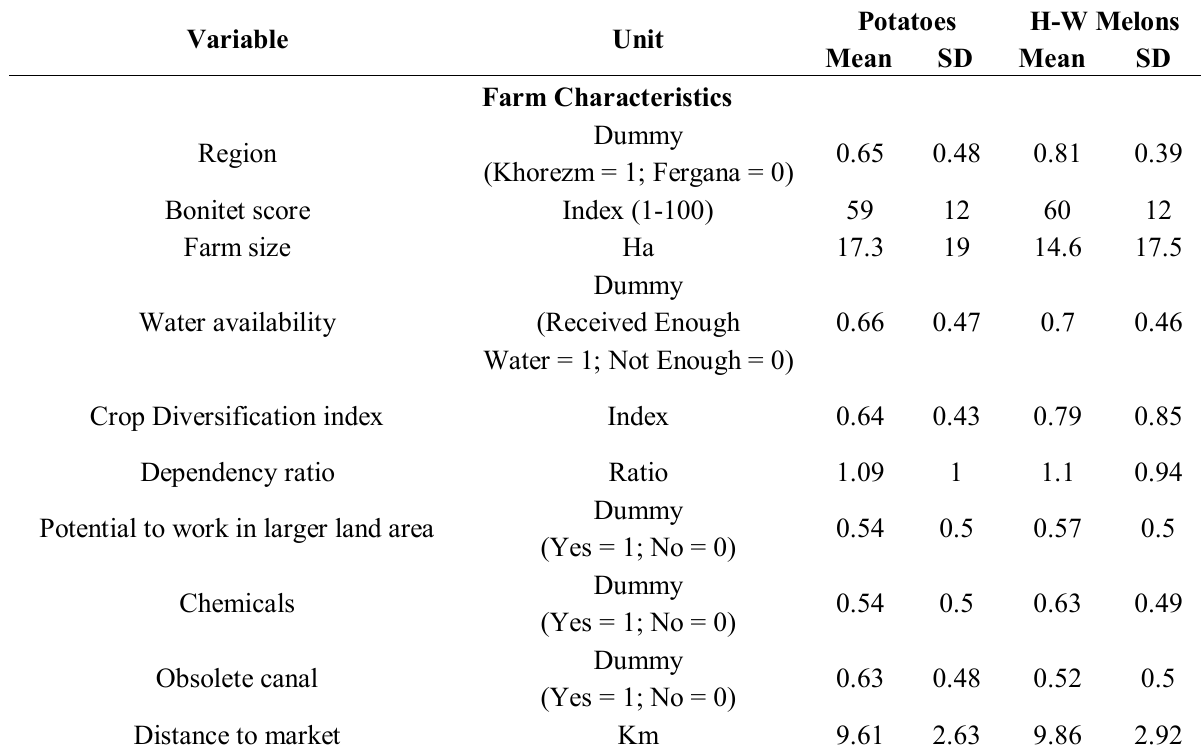
Table A1. Summary statistics of farm characteristics for DEA